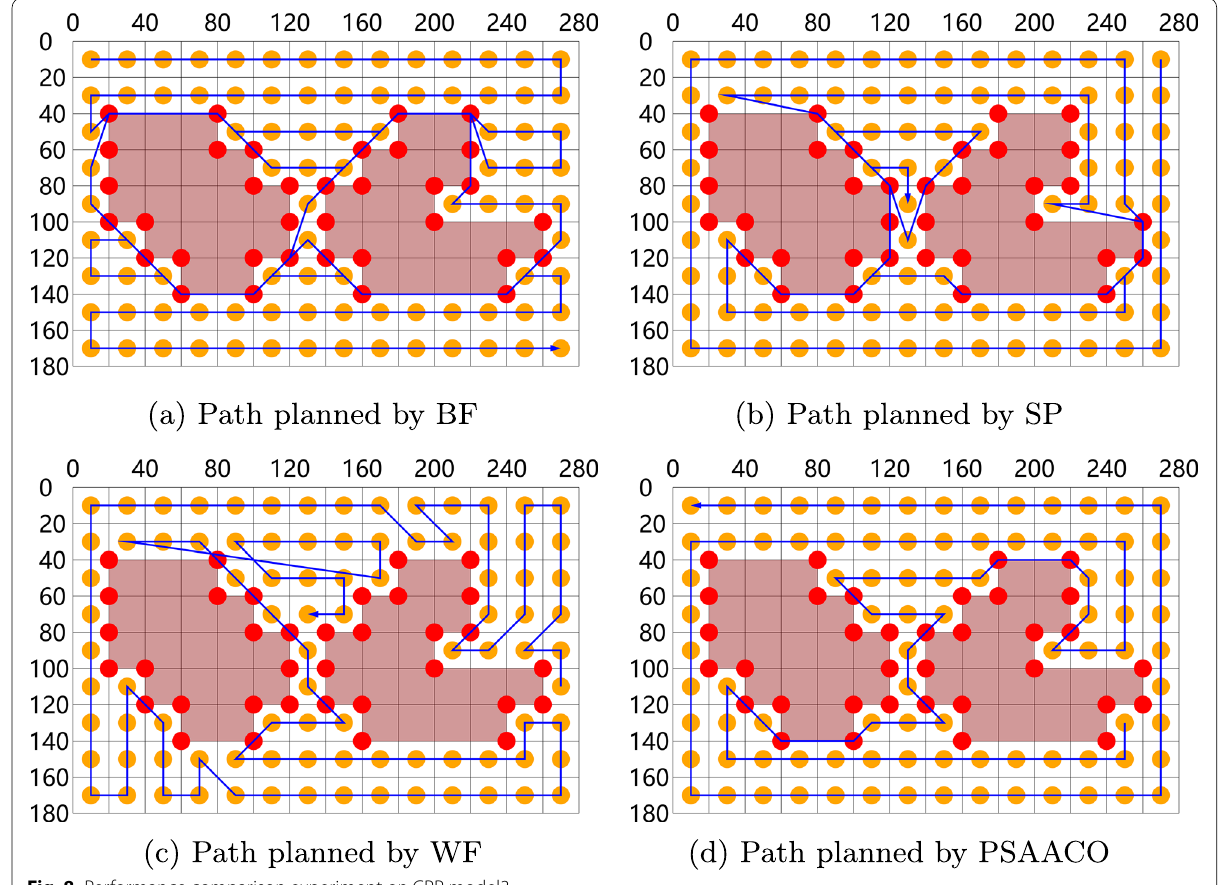
Fig. 8 Performance comparison experiment on CPP